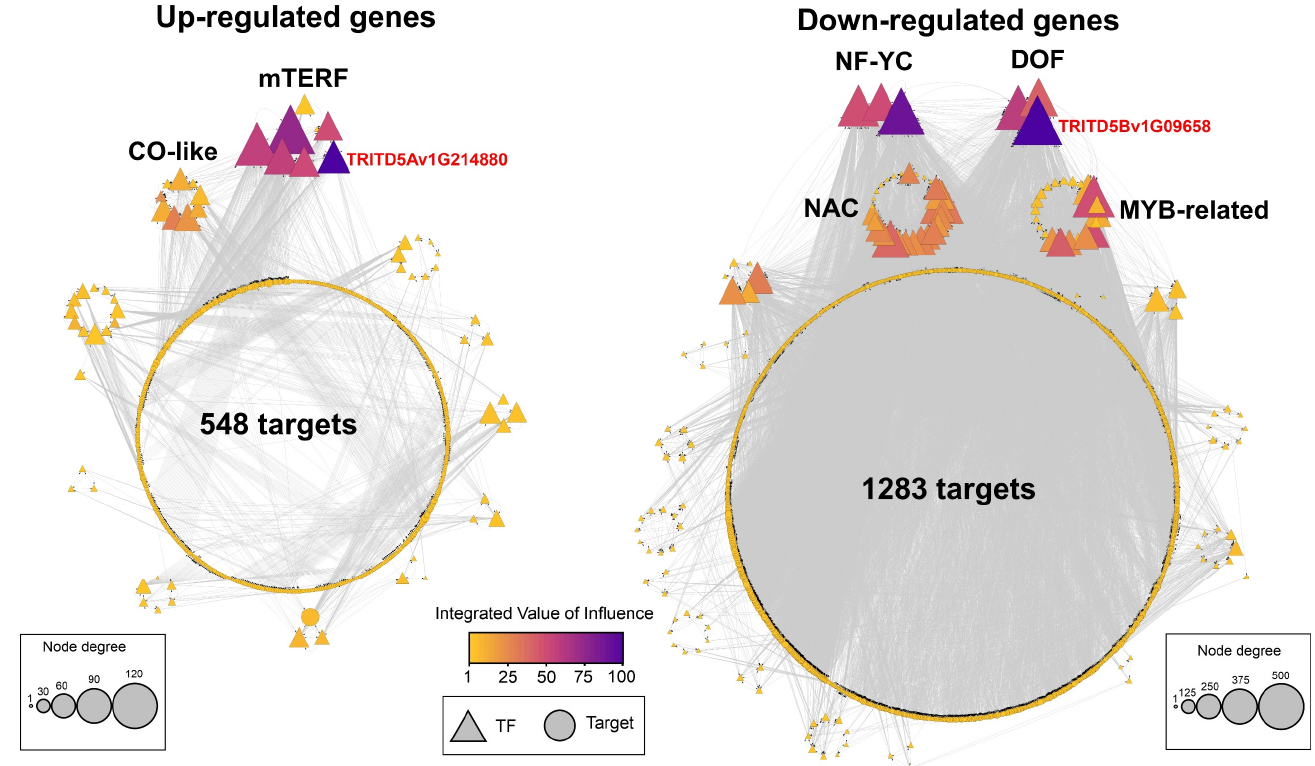
Figure 6. TF-target gene regulatory network based on DEGs from heat stress in durum grain wheat. Triangles represent TFs; circles represent targets. Gray lines denote the TF-target connections. TF, transcription factor. The color gradients from yellow to purple represent the integrated value of influence for each network [50].